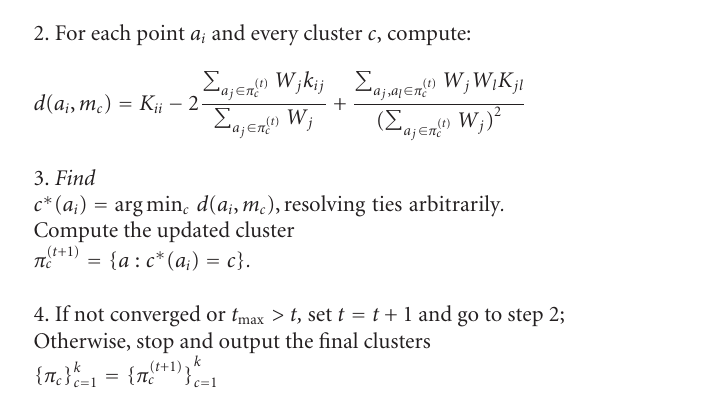
Algorithm 1: Graph partition algorithm (Weighted Kernel k -means). This algorithm assigns the voxel a i to the cluster π c if the cluster π c minimizes the distance function from point 2